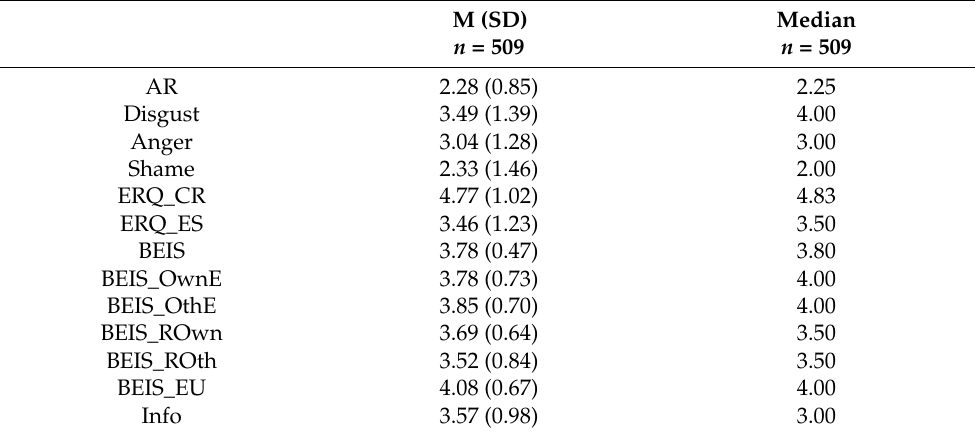
Table 2. Descriptive statistics for the aggressive reactions (AR), negative emotions, emotion regulation questionnaire (ERQ), and brief emotional intelligence scale (BEIS)-10.